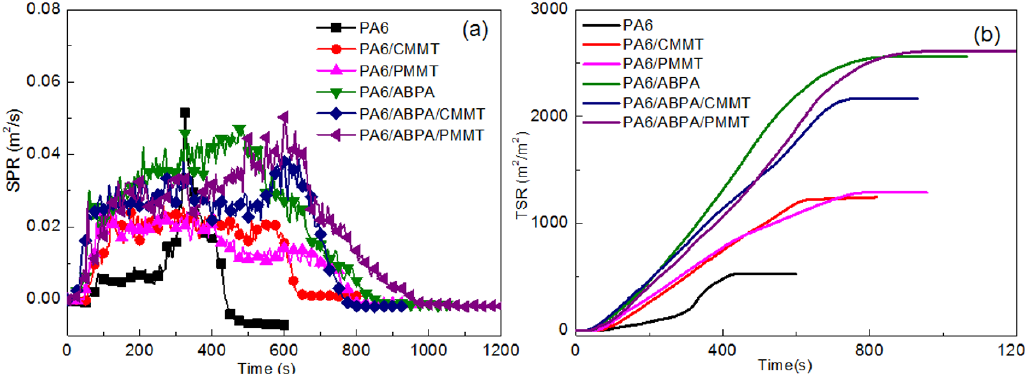
Figure 7. Smoke production rate (SPR, ( a )) and total smoke production (TSP, ( b )) plots of PA6 and PA6 composites.